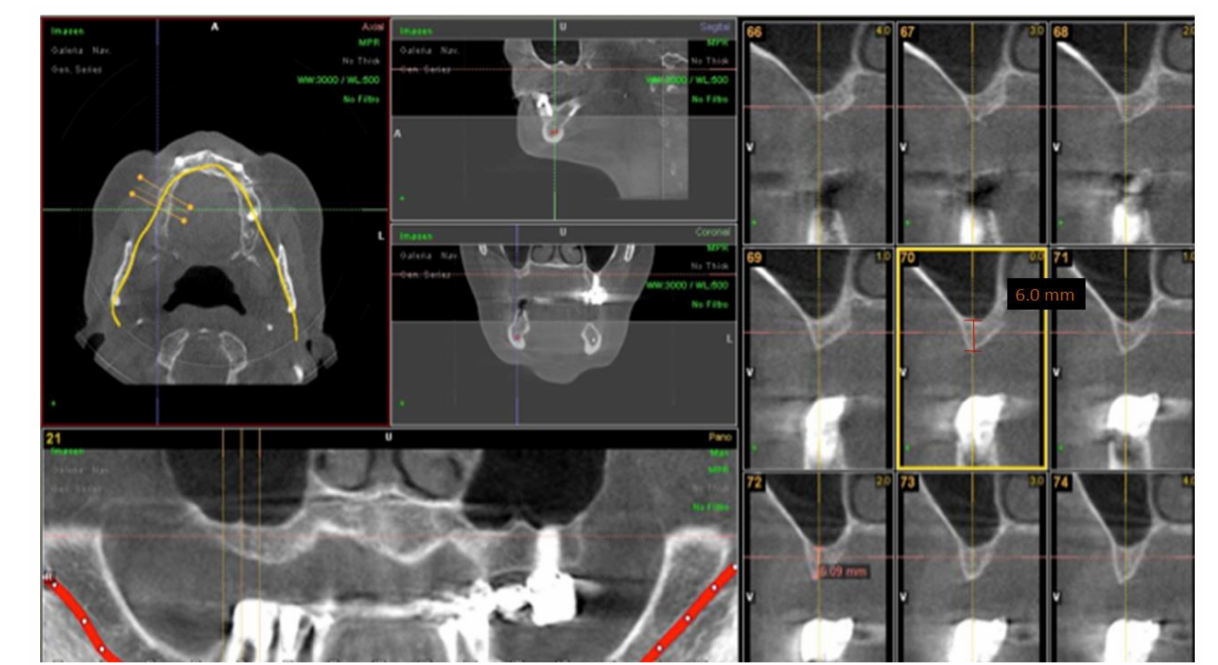
Figure 1. CBCT prior to maxillary sinus elevation